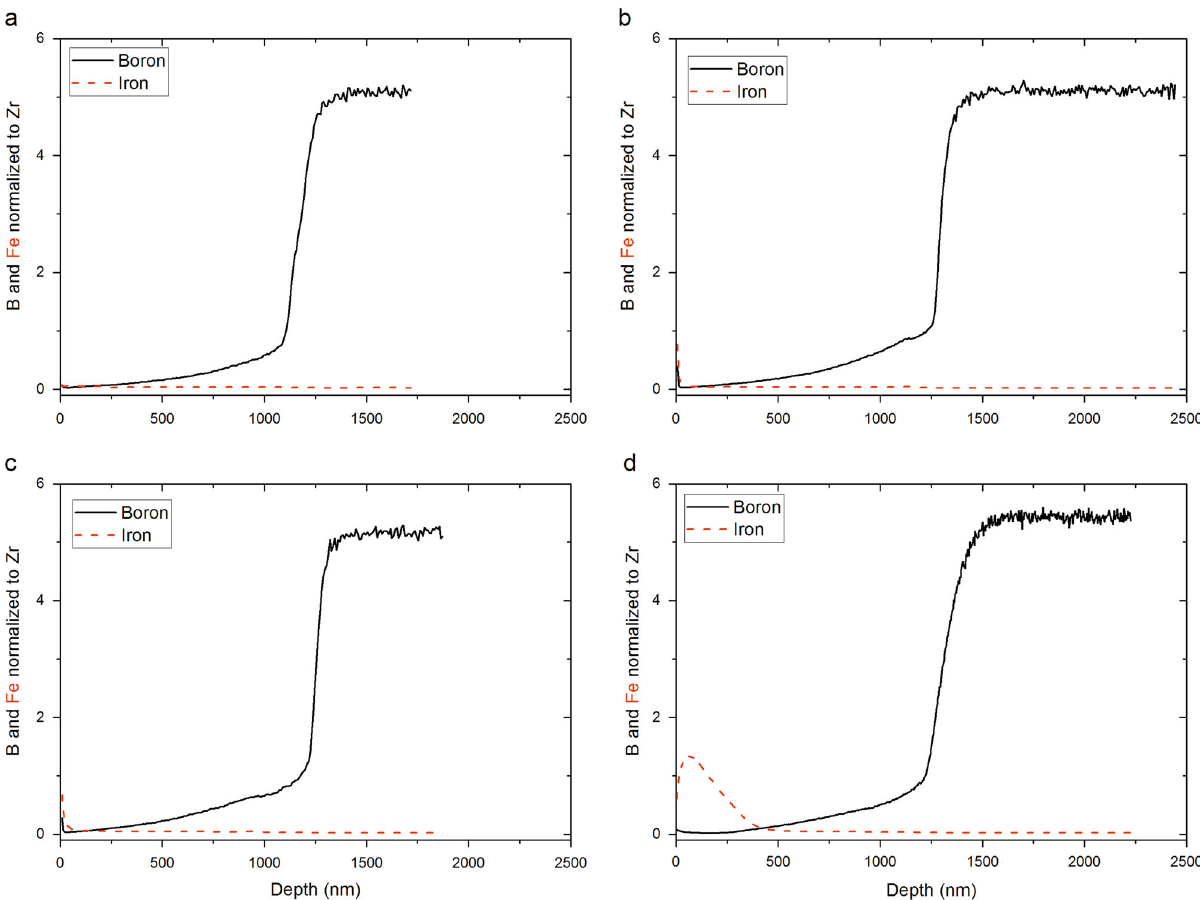
Fig. 5 TOF-SIMS elements pro fi les for iron ( red ) and boron ( black ) of the polished surface of each monolith. The boron pro fi le is shown as a measurement of the alteration layer thickness at each time point. a day 70: before addition of magnetite E th = 1.17 µm; b day 83: 2 weeks after addition E th = 1.29 µm; c day 126: 2 months after addition E th = 1.25 µm; d day 246: 6 months after addition E th = 1.26 µm. Depths were measured by pro fi lometry during TOF-SIMS analysis